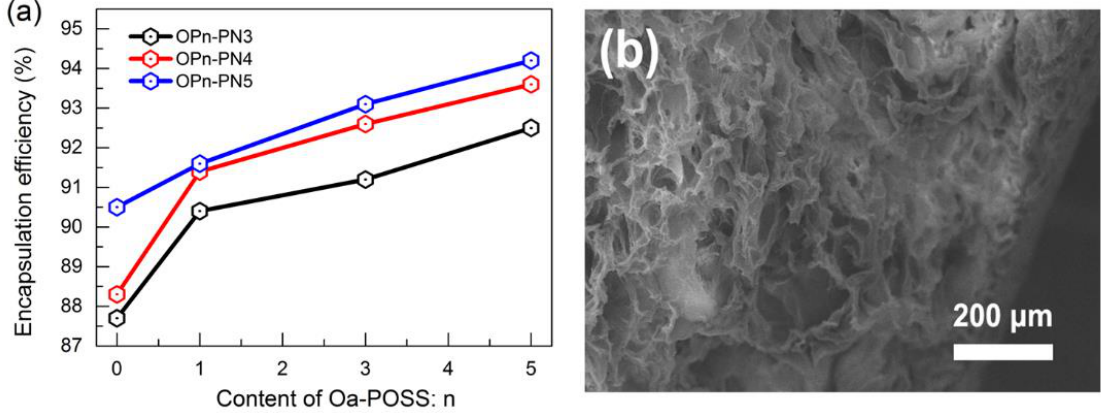
Figure 9. Drug-loading character of OPn-PNm gels: ( a ) drug loading content as a function of n and m for OPn-PNm gels; ( b ) SEM image of drug-loaded OP5-PN5 gels treated by freeze-drying.